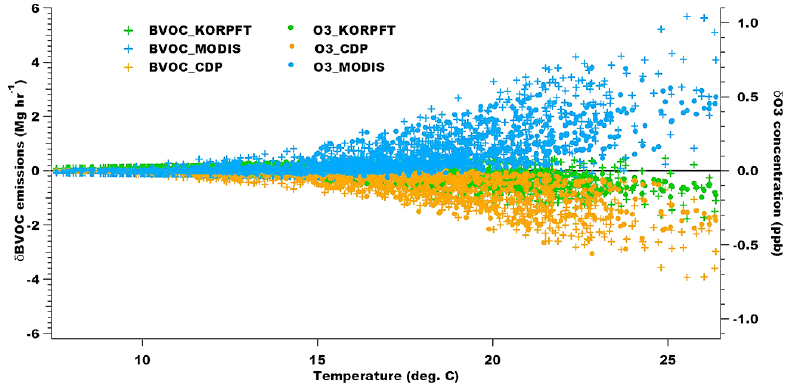
Figure 11. Divergence of the predicted hourly BVOC emissions and O 3 concentrations with temperature change in the modeling domain. Every displayed value of δ BVOC and δ O 3 in this figure was derived from the hourly domain-averaged values of the MEGAN BVOC emissions and CMAQ O 3 concentrations for the three PFT scenarios (e.g., KORPFT, CDP, and MODIS). The temperature on the horizontal axis in this figure represents averaged values of MM5-predicted ambient